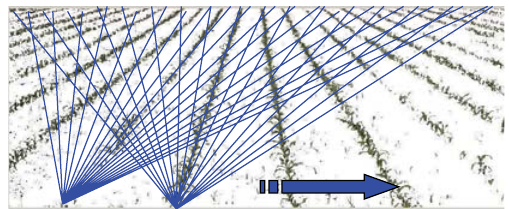
Figure 5: Lines traced from every pixel of the bottom row in the image.